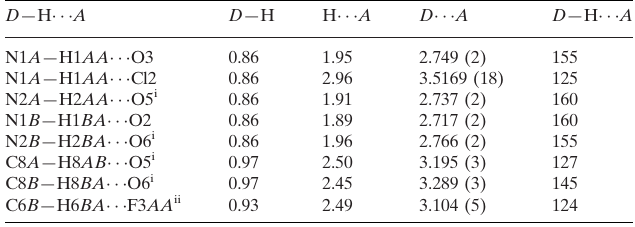
independent cations of a lansoprazole {systematic name 2-([3- methyl-4-(2,2,2-trifluoroethoxy)pyridin-2-yl]methylsulfinyl)- 1 H -benzo[ d ]imidazole} intermediate and a dianion of chlor-